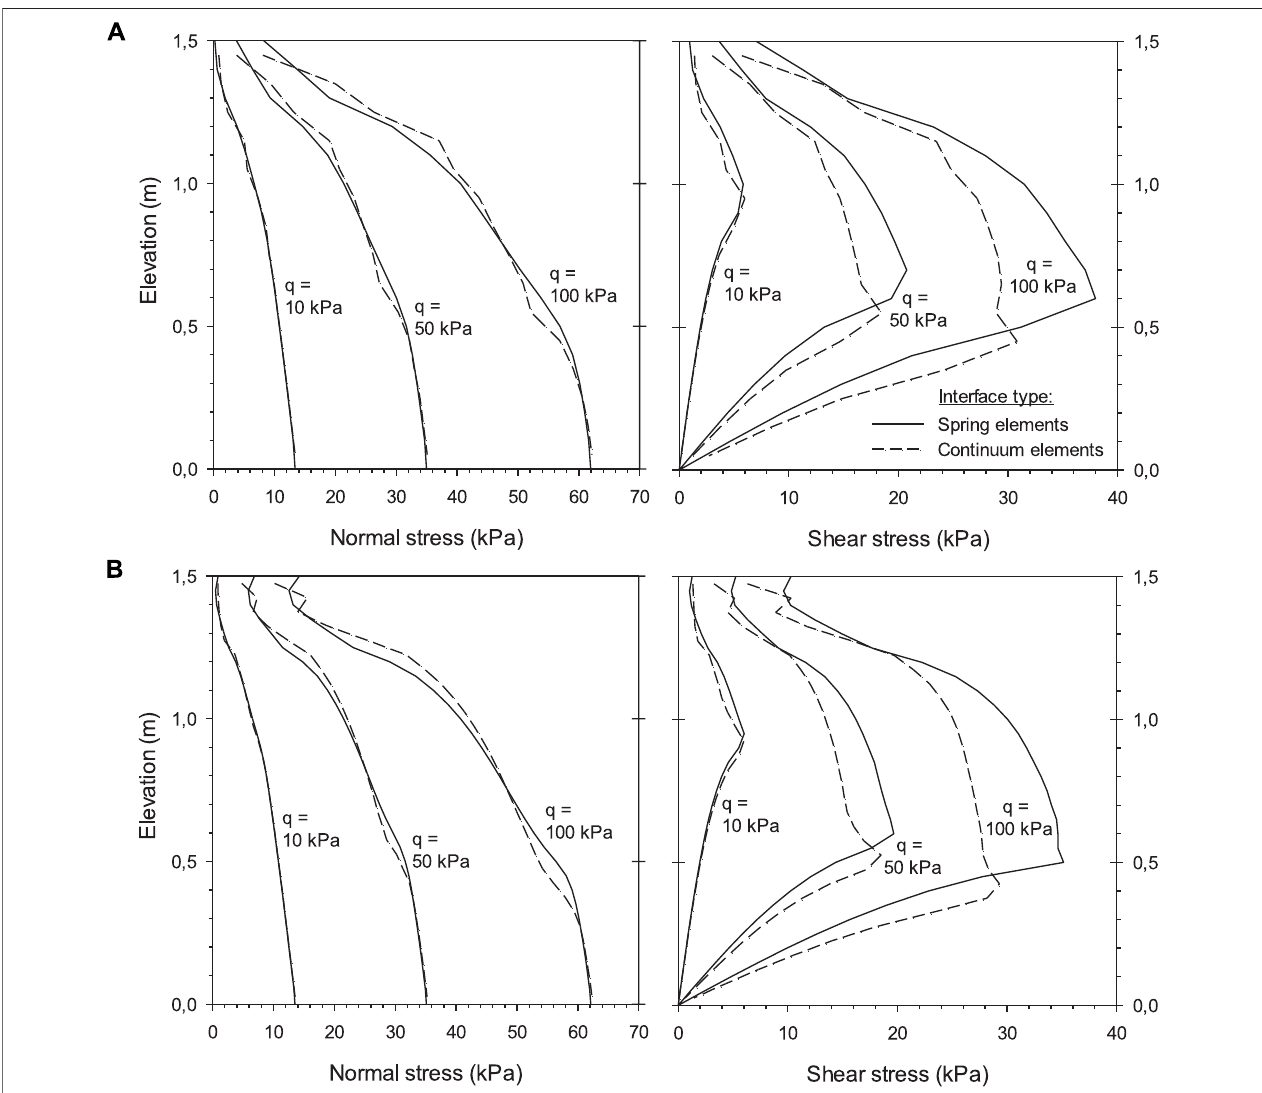
FIGURE 5 | Comparison of load transfer results from back fi llsoil to facing panel using FLAC with (A) coarse mesh and (B) fi ne mesh: normal and shear stresses at the interface between the facing structure and back fi ll soil for a strength/stiffness reduction factor Ri = 0.8.